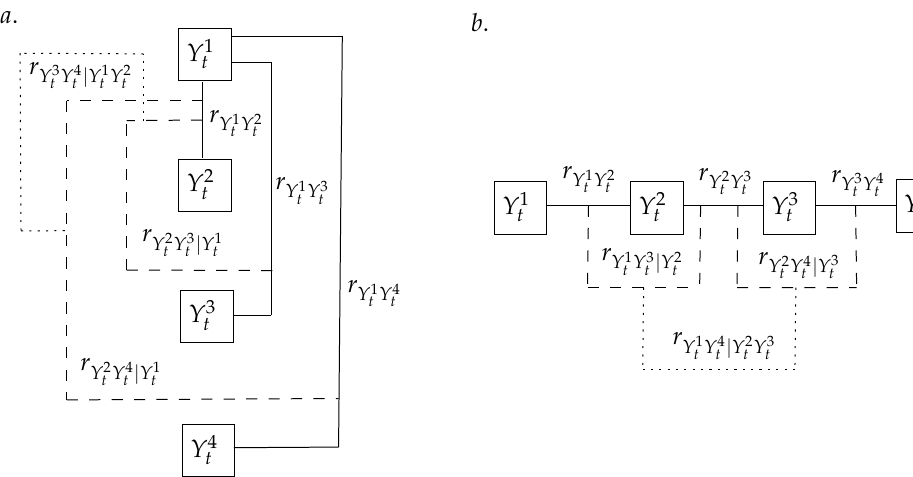
Figure 3. Graphical representation of four-dimensional C-vine ( a ) and D-vine ( b ). Figures recon- structed from [54], with permission from